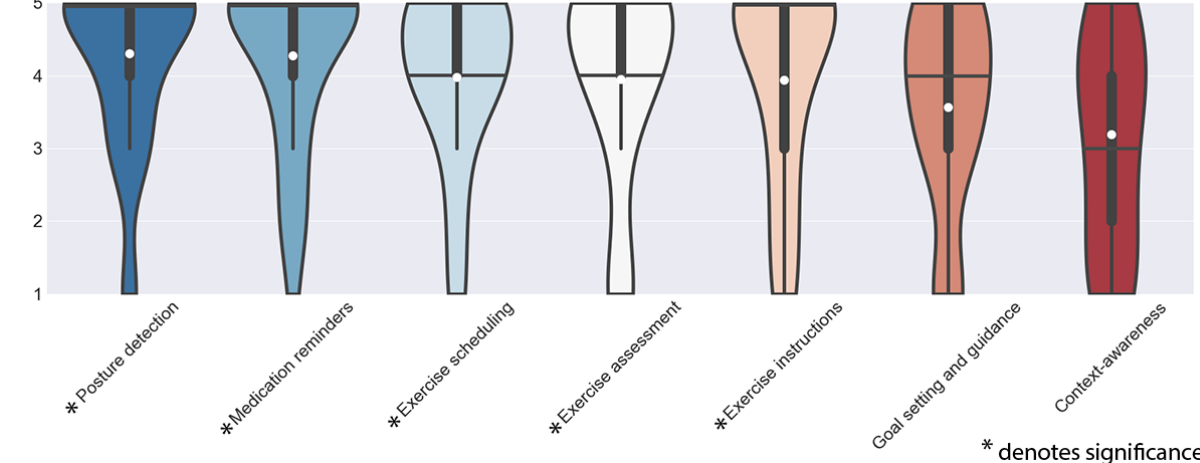
=4.20, σ =1.17) was rated highest x x